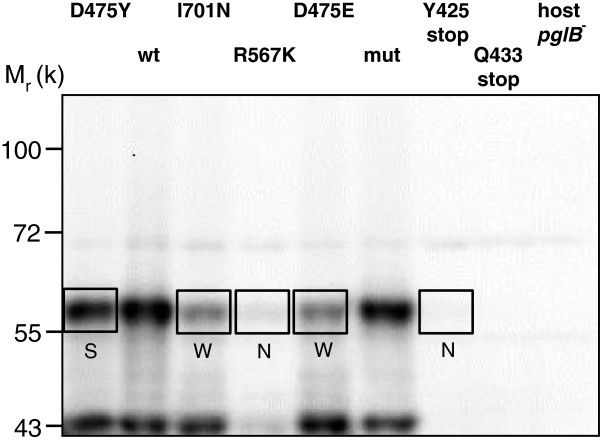
Analysis of PglB expression by anti-HA Western blot. Selected inactive clones of epPCR libraries (PglB mutations given in lane header) and control strains were grown and induced in DWP. wt: pGVXN112Kan, mut: pGVXN113Kan, host: E. coli CLM24 (pGVXN150, pGVXN345). Relative expression levels of full-length PglB given in subsequent Figures and Tables were determined from the upper, boxed bands by image analysis with the software ImageJ (wt PglB = 100%, S = strong, W = weak, N = negative).